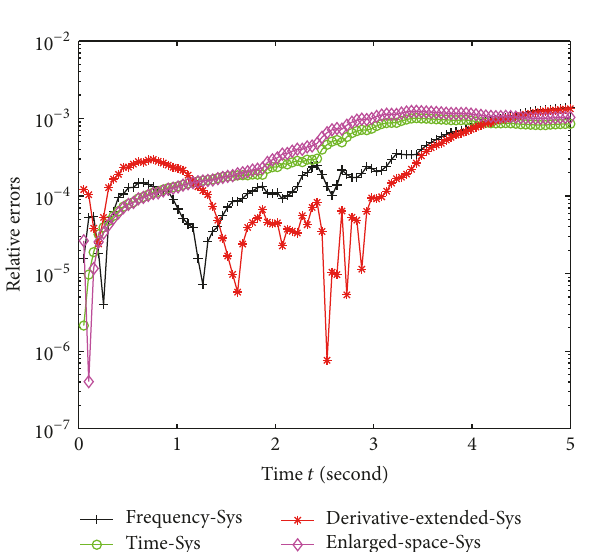
Figure 4: Relative errors of reduced models with different reduced